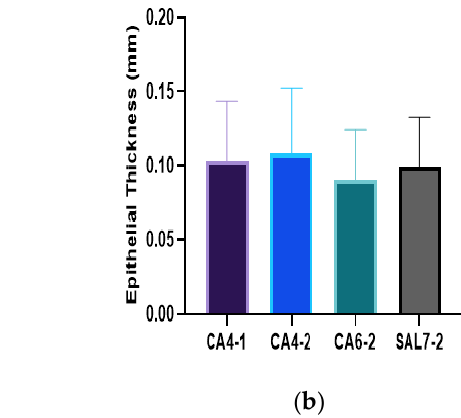
epithelial thickness was observed following treatment of PA4-2 and PA6-2, with p -values of 0.0384 and 0.0354, respectively.